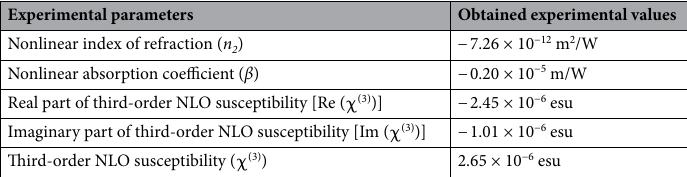
Table 1. The Third-order NLO parameters of Lycopene.